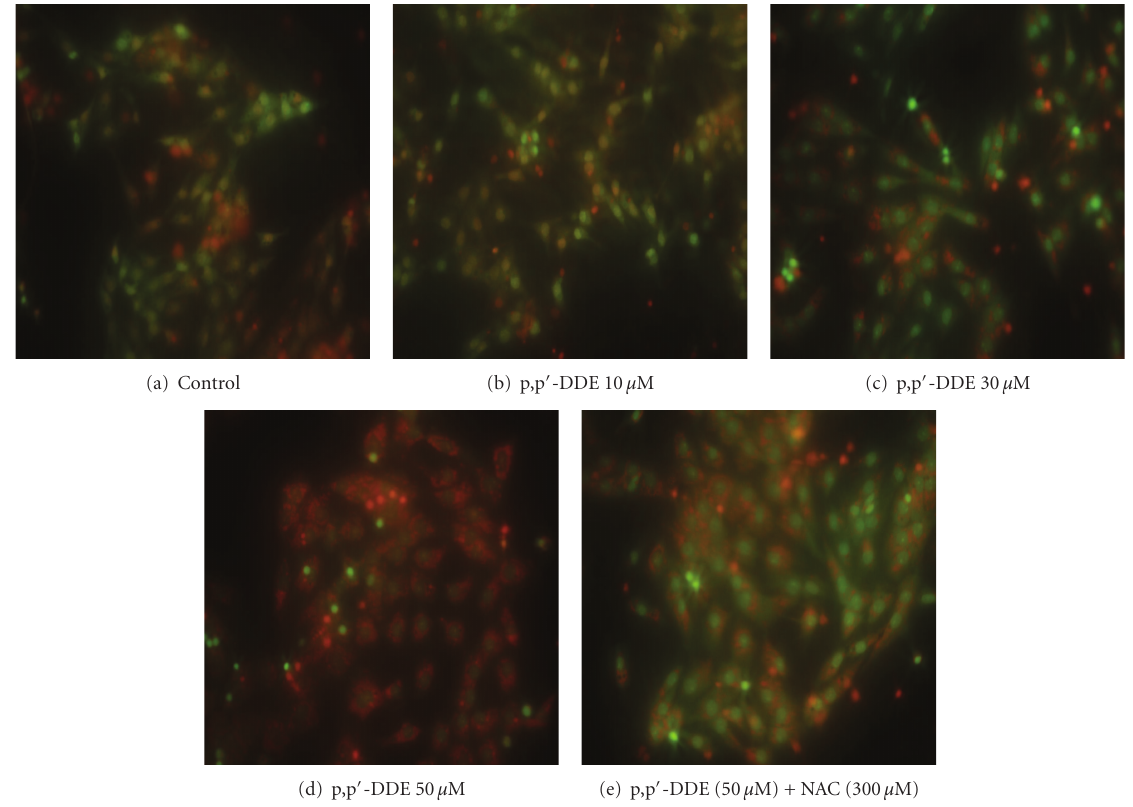
Figure 2: Morphological observation of apoptotic e ff ects of Sertoli cells treated with p,p (cid:2) -DDE with or without NAC under a fluorescence microscope. Cells in control group (a) and cells treated with 10, 30, 50 μ M p,p (cid:2) -DDE, and 50 μ M p,p (cid:2) -DDE with NAC (b, c, d, and e) were observed by AO/EB staining. Original magnification is ×